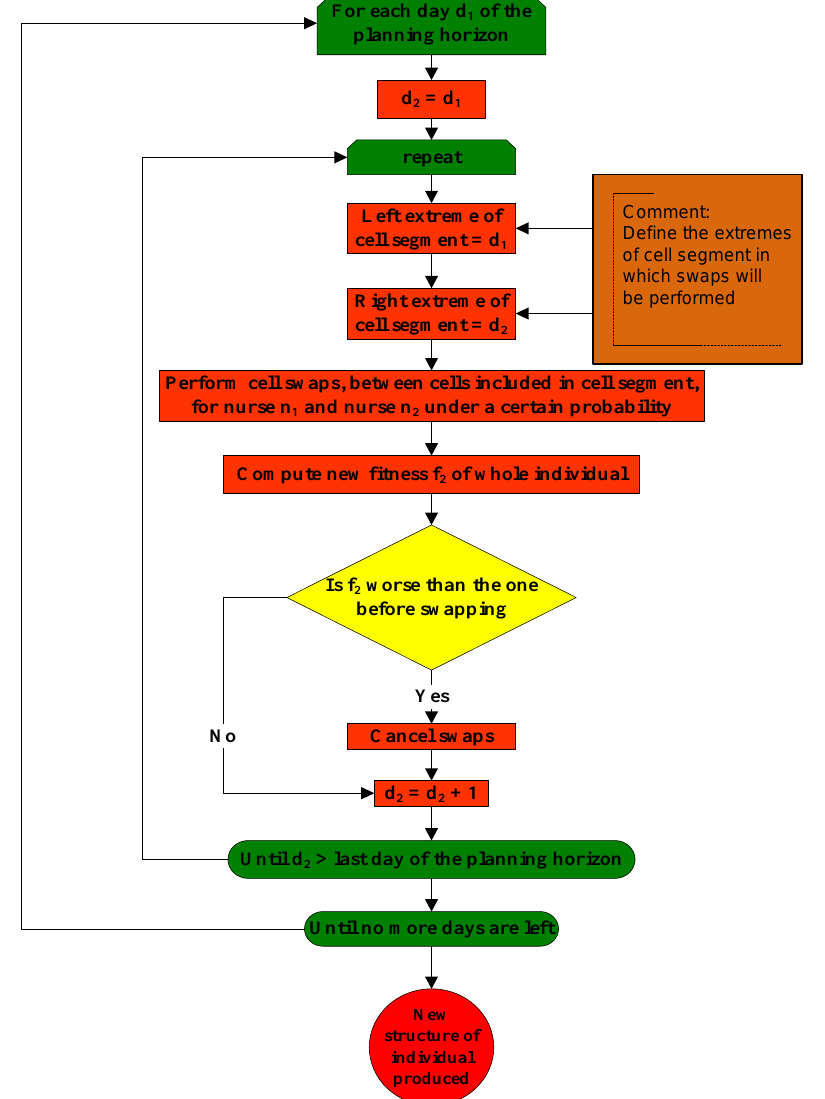
Figure 4. The structure of the procedure, Selective_Partial_Swap (). For each day d 1 of the planning horizon